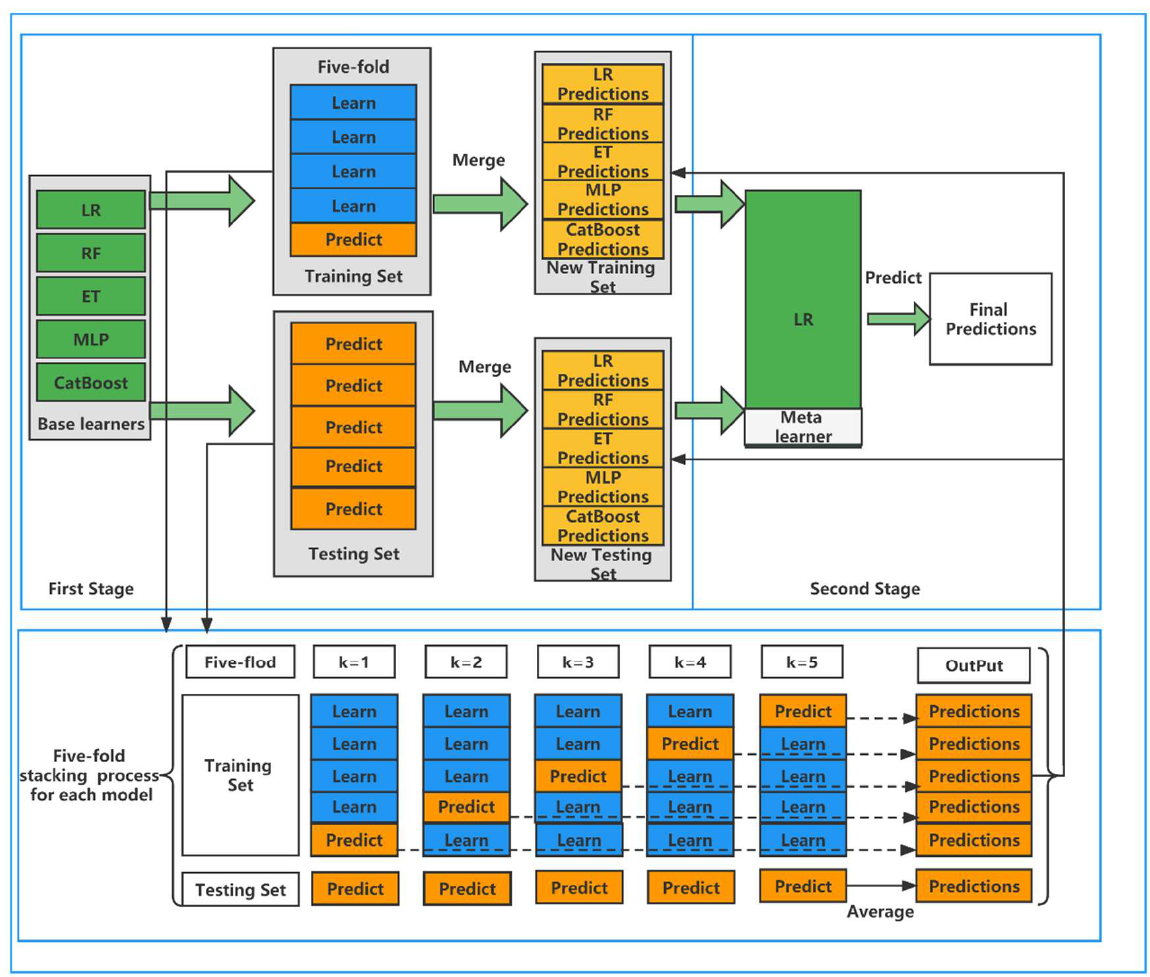
Figure 2. The stacking ensemble learning model.